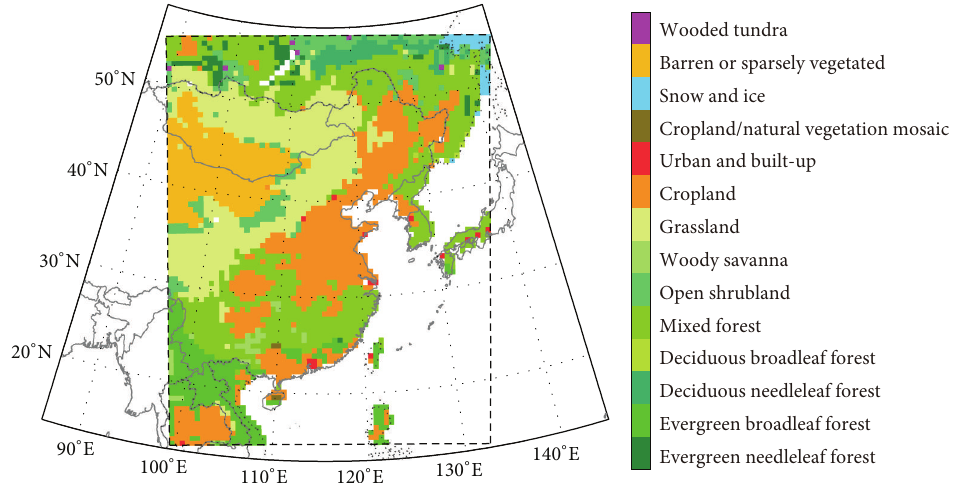
Figure 1: Simulation domain (black-dashed line) and land cover (derived from MODIS land cover products released together with WRF surface static